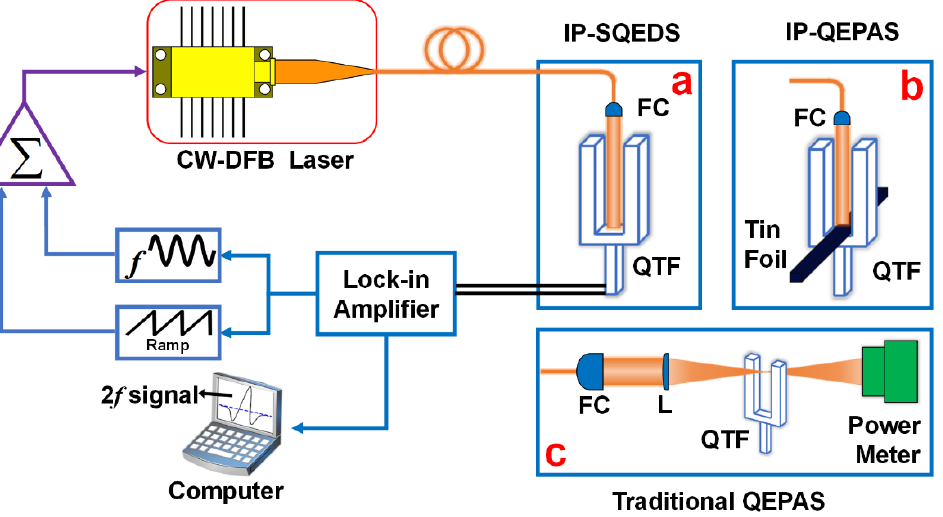
Figure 2. Schematic diagram of experimental design: ( a ) IP-SQEDS; ( b ) IP-QEPAS; ( c ) traditional QEPAS.